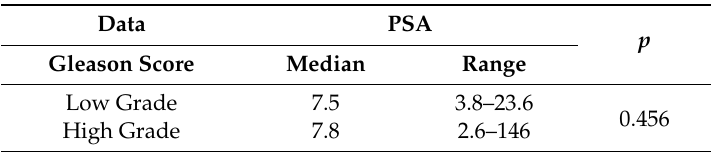
Table 3. Comparison of median PSA levels in relation to Gleason Score—group A + B. Values are presented as